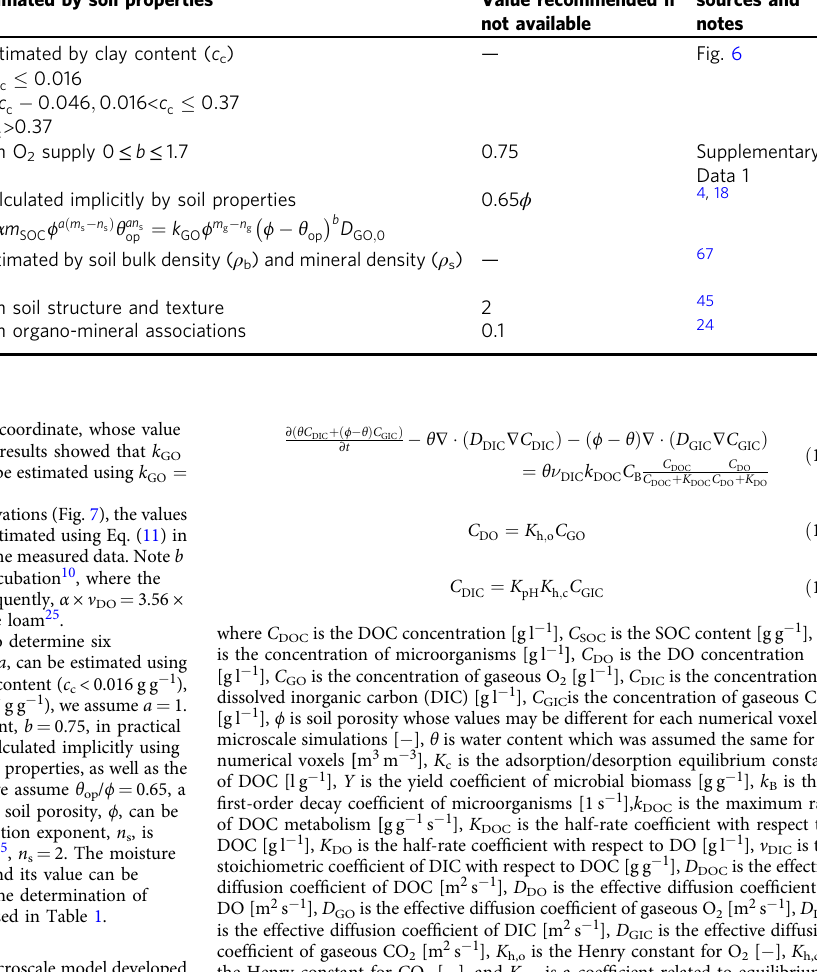
Table 1 Determinations of parameter values in the application of f m Parameters